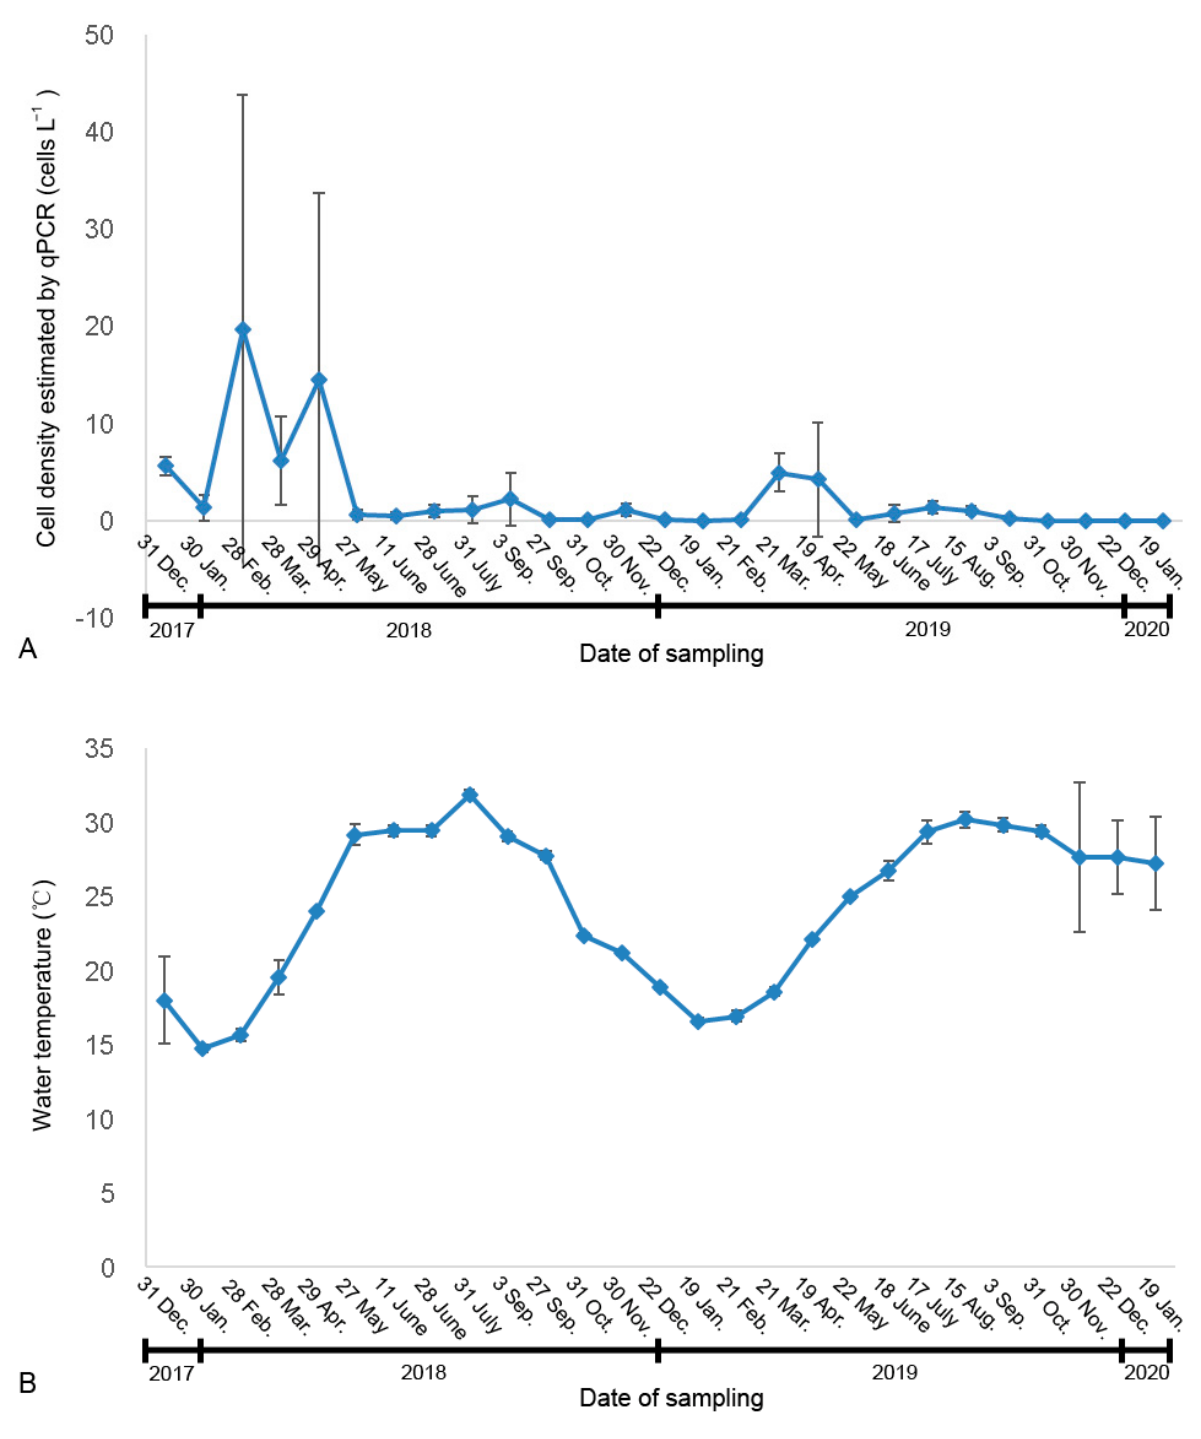
Figure 6. Average cell abundance (cells L − 1 ) of Alexandrium pacificum in water samples from the three stations in Xiamen Bay from December 2017 to January 2020. ( A ) Average cell abundance examined by qPCR and ( B ) average water temperature of the three stations in Xiamen Bay.